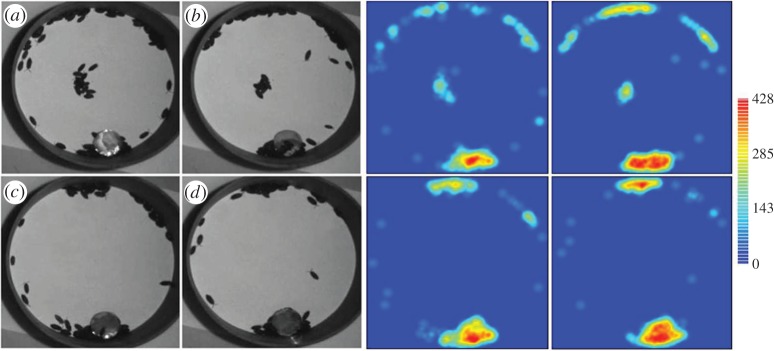
An example of aggregation dynamics in the arena with one shelter of ø 3.5 cm and 100 woodlice at t=5 min (a), t=10 min (b), t=30 min (c) and t=45 min (d), and its representation using Kernel density on the right side (paraboloid function). See other examples in the electronic supplementary material, figure S2.